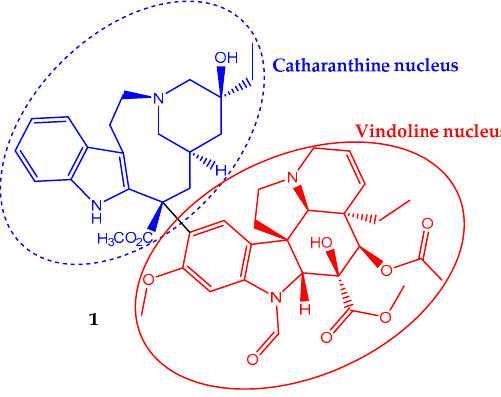
Figure 1. Chemical structure of the vinca alkaloid vincristine ( 1 ), an anticancer natural agent that repress cell growth by altering the microtubular dynamics.